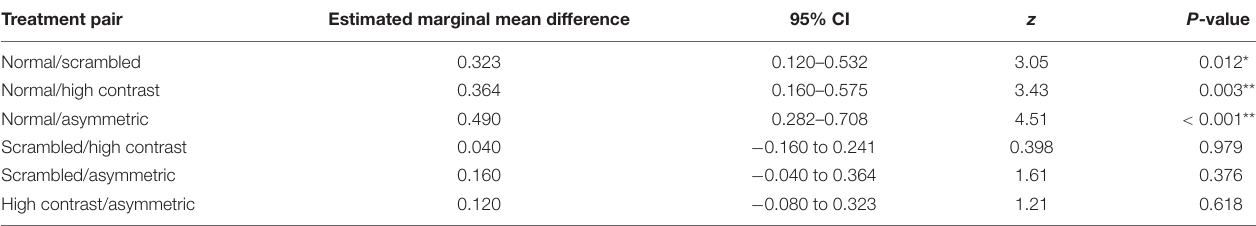
FIGURE 5 | Mean proportion of correct choices by experienced bees for normal (NF), scrambled (SF), high contrast (HCF), and asymmetric scrambled (ASF) flowers for trial blocks 1 (A) and 2 (B) . Error bars represent the 95% confidence intervals for the mean number of proportions and letters indicate statistically significant difference between normal flowers (NF) and the three experimental conditions. Refer to Table 2 for the level of significance of each comparison. Grey line indicates chance level performance [p(C) = 50%]. Letters in panel (B) indicate significant differences between the manipulated flower groups and the normal flower group, which was used as a baseline for the analyses. TABLE 1 | Pairwise comparisons of the marginal mean of proportions observed by a group of experienced bees for each treatment level during the training phase. Treatment pair